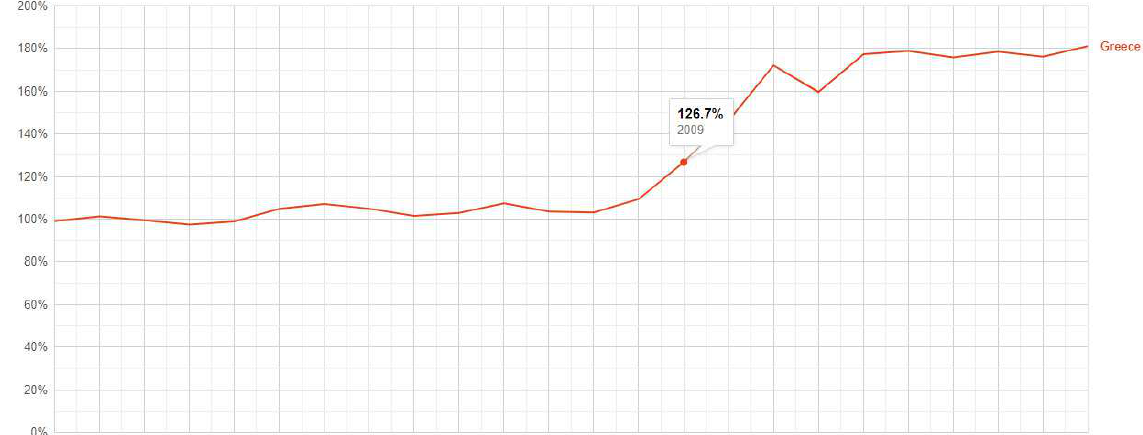
Figure 9. Greek government debt as a percent of GDP